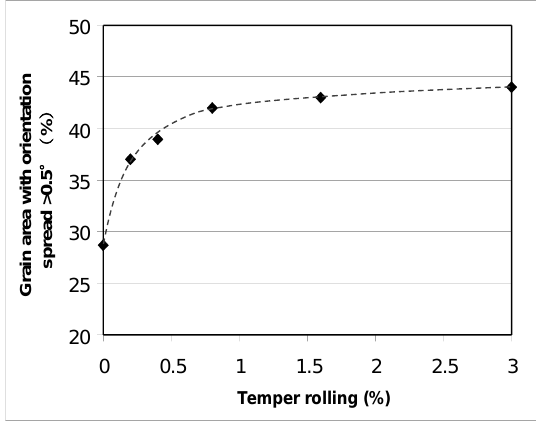
Figure 11. EBSD measurements showing the relationship between the temper-rolling reduction and the grain areas with orientation spread > 0.5°(black rhombus as measured points).